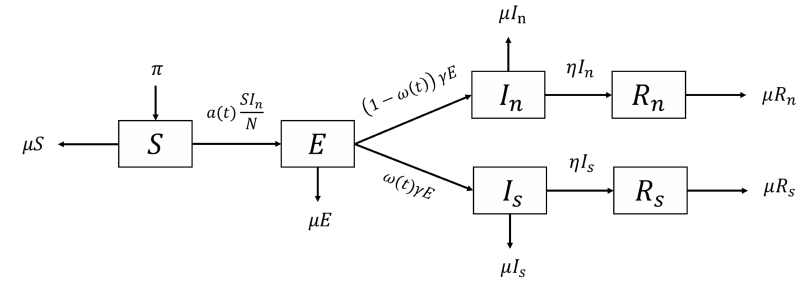
Figure 3. Flow diagram of the generalized SEIR